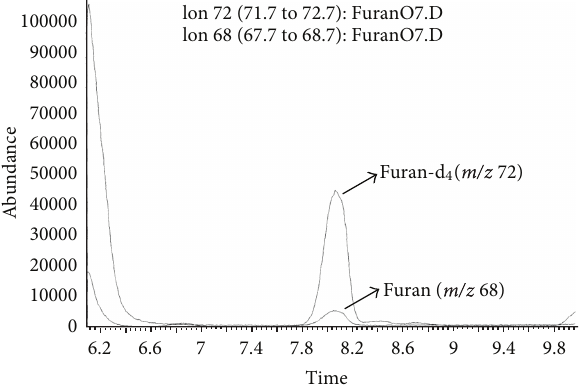
F 2: Furan levels obtained aer reheating (for illustration purposes: levels below limit of detection (LOD) were considered as half of LOD (0.35 g/kg) and levels below limit of quanti�cation (LOQ) were considered as half of LOQ (1.2 𝜇𝜇 𝜇𝜇